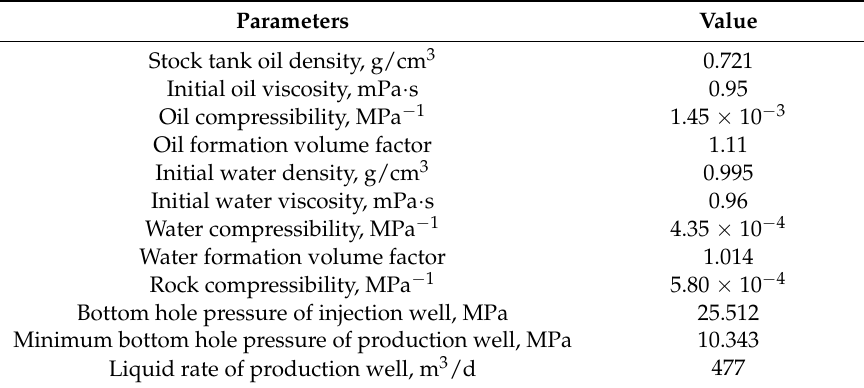
Table 7. Fluid property, rock property and production data of the case.